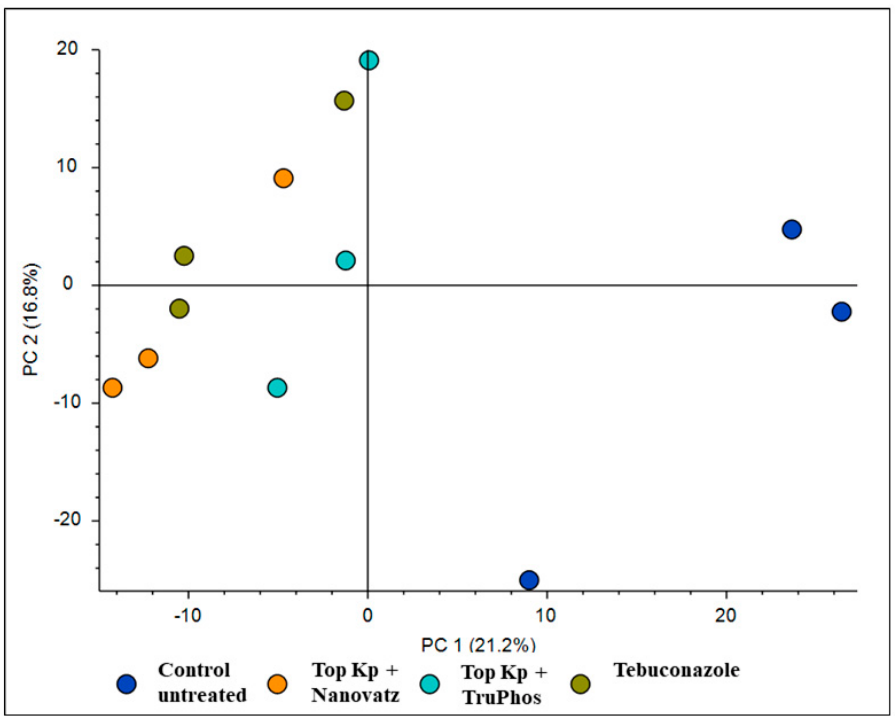
Figure 1. PCA analysis for 840 compounds identified by LC-MS/MS in cv. Riesling grape skin tissues treated by the fungicide Folicur (tebuconazole) 0.02%, Top KP+ 1% plus Nanovatz 0.1%, or Top KP+ 1% plus TruPhos 0.25% and untreated grapes.